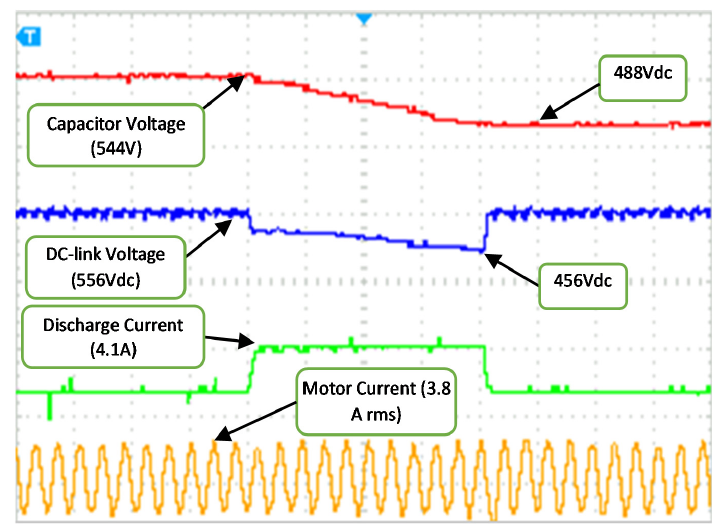
Figure 14. Experimental results with dc-link voltage compensation.